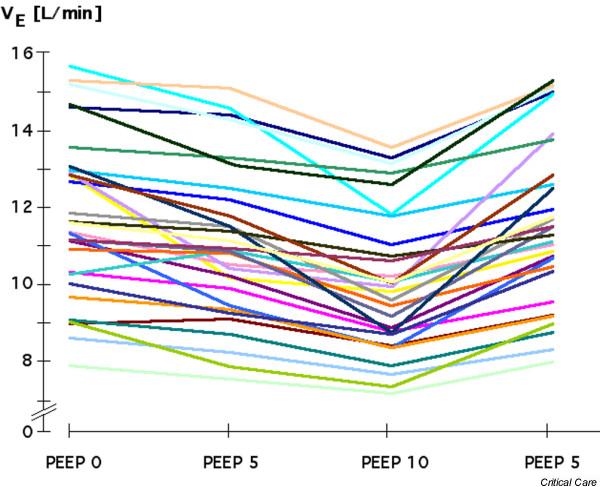
Short-term effects of PEEP on VE in the individual patient. Results are from the investigation with PEEP steps of 30 s duration, and each coloured line shows findings for a different patient. Although VE is dispersed over a wide range, its behaviour was similar between patients (i.e. VE decreased with increasing levels of PEEP, and vice versa). PEEP, positive end-expiratory pressure; VE, minute ventilation.